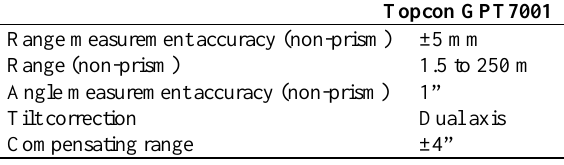
Table 2. Total Station technical specifications.